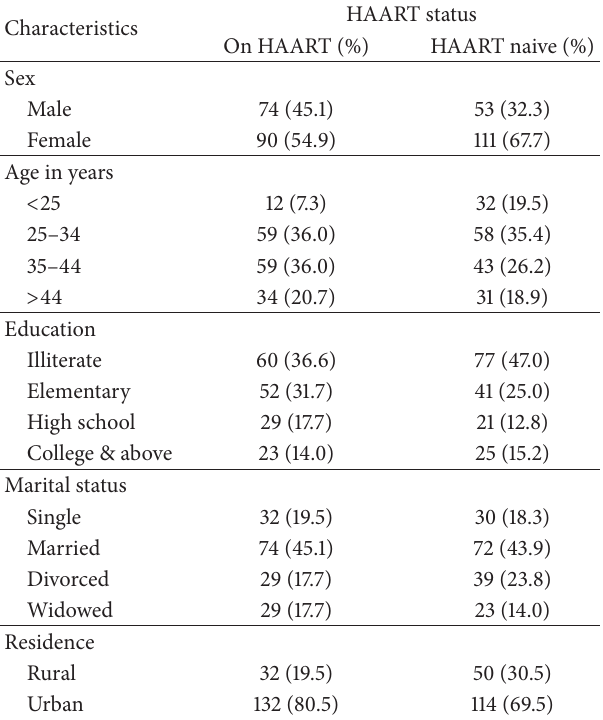
Table 2: Clinical and immunological profile of HIV-1 patients at Debre Tabor Hospital,